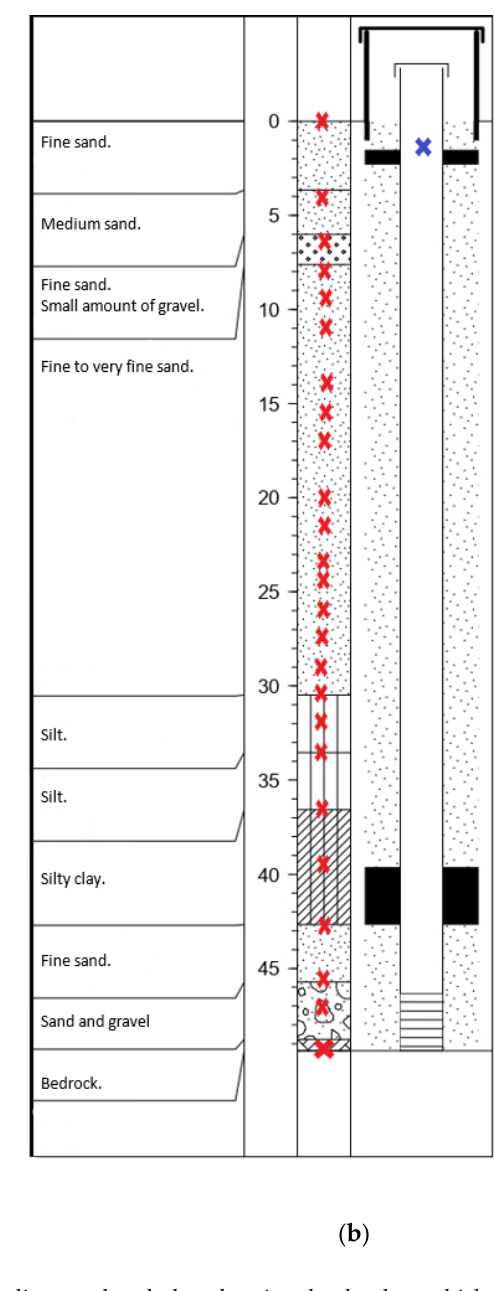
Figure 2. Diagrams of the 15.2 cm diameter boreholes, showing the depth at which samples of rock- associated (red crosses, sediments samples during drilling) and planktonic (blue crosses, samples in the well water after drilling) subsurface communities were taken ( a ) at site 1 (Ascension) and ( b ) site 2 (Notre-Dame-du-Laus).